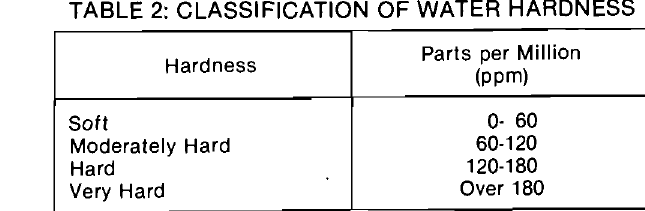
TABLE 2: CLASSIFICATION OF WATER HARDNESS